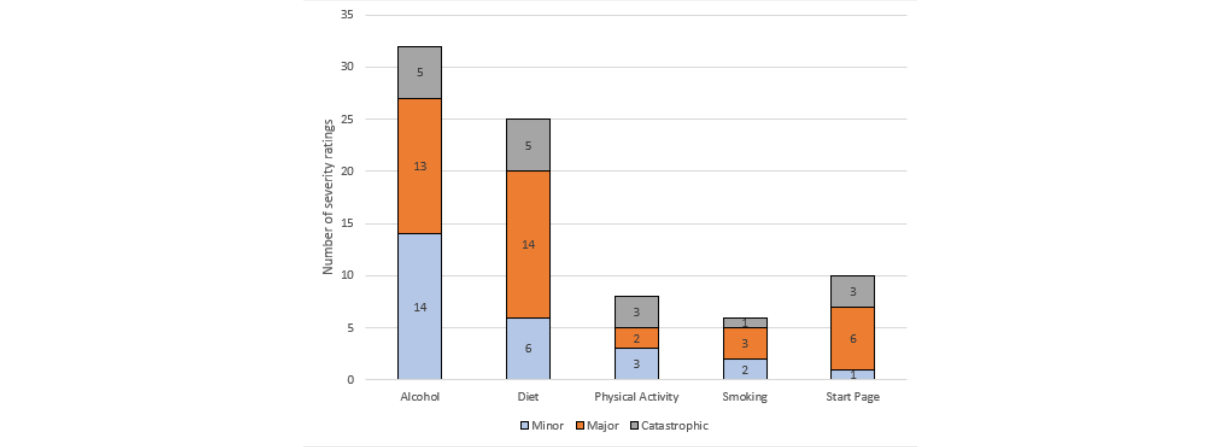
Figure 2. Number of severity ratings (minor, major, and catastrophic) for each module as reported by the 15